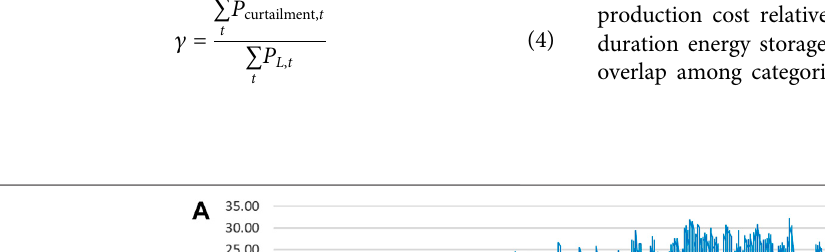
Frontiers in Energy Research |